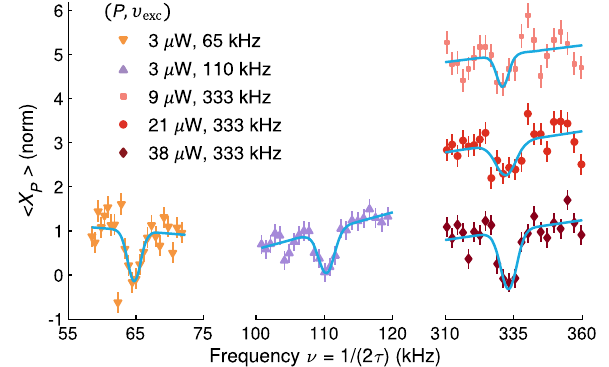
FIG. 6. Detection of unsynchronized, variable-frequency ac photocurrents. We show the X projection of the final NV state using an unsynchronized XY8-8 sensing sequence. The photo- excitation repetition rate ν is fixed for each set, and the exc repetition rate of the NV driving pulses ν ¼ 1 = 2 τ is scanned.